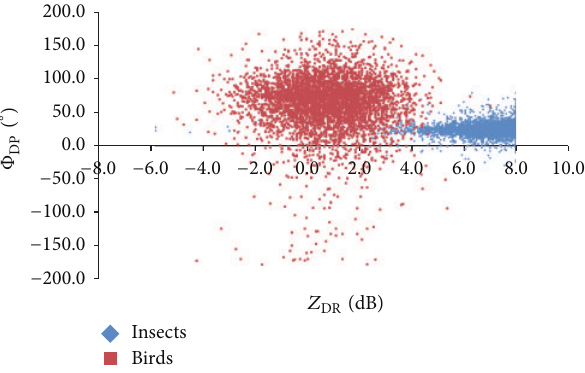
Figure 3: 𝑍 – Φ scattergrams for BSb (plotted by red dots) and DR DP BSi (plotted by blue dots) constructed by 1692359 and 1385090 pixels of “ground-truth” data gathered from the KICT observations during the nighttime and daytime, respectively, on 2 October